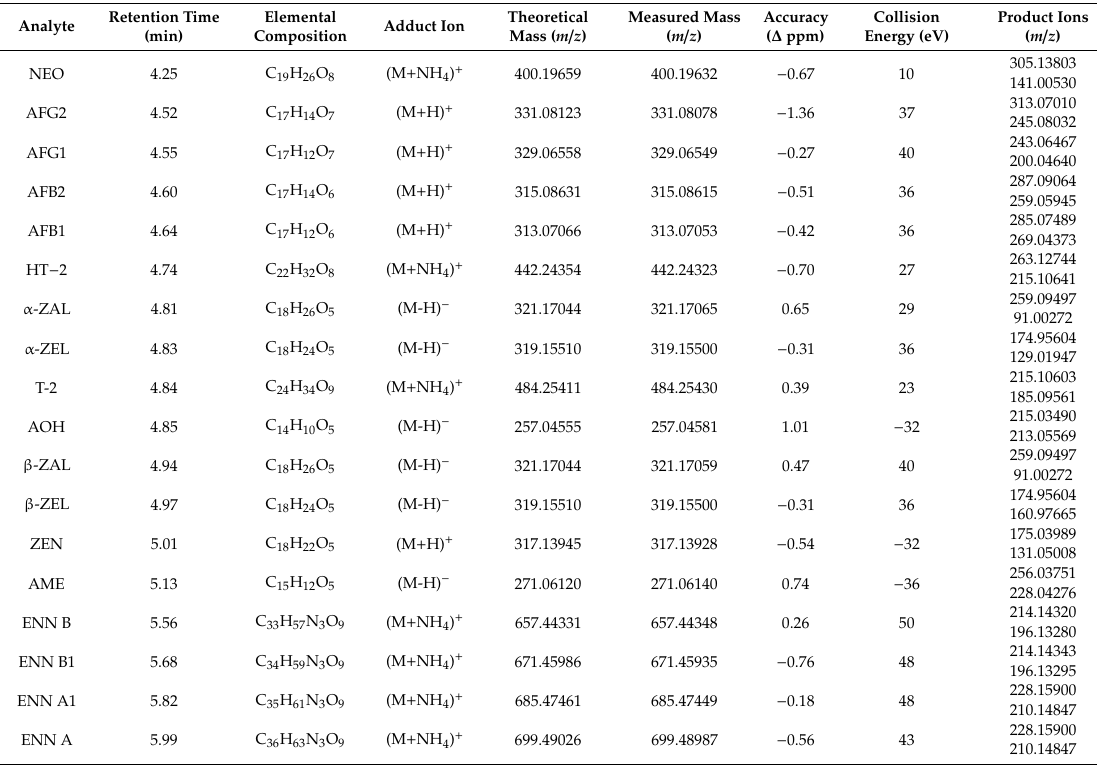
Table 6. UHPLC-HRMS parameters corresponding to the here-analyzed